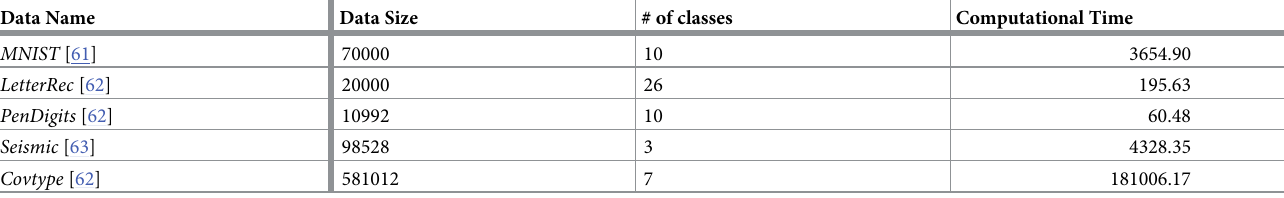
Table 1. Computational times of five datasets for spectral